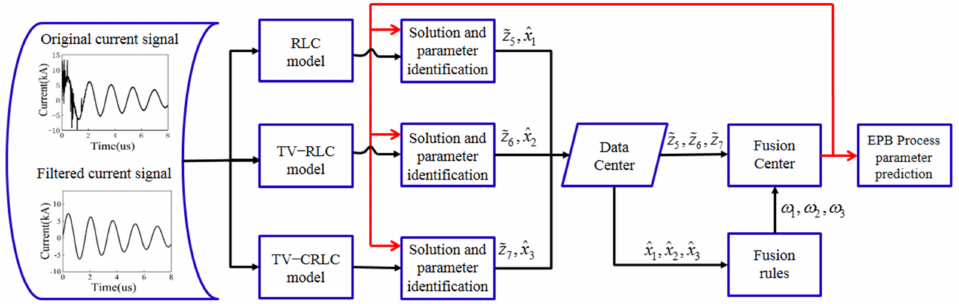
Figure 2. Multi-model fusion framework of discharge circuit for high-voltage EPB